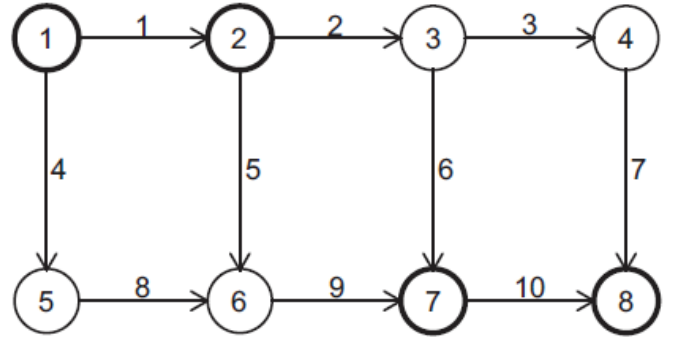
Figure 2. Network used in the numerical studies (adapted from